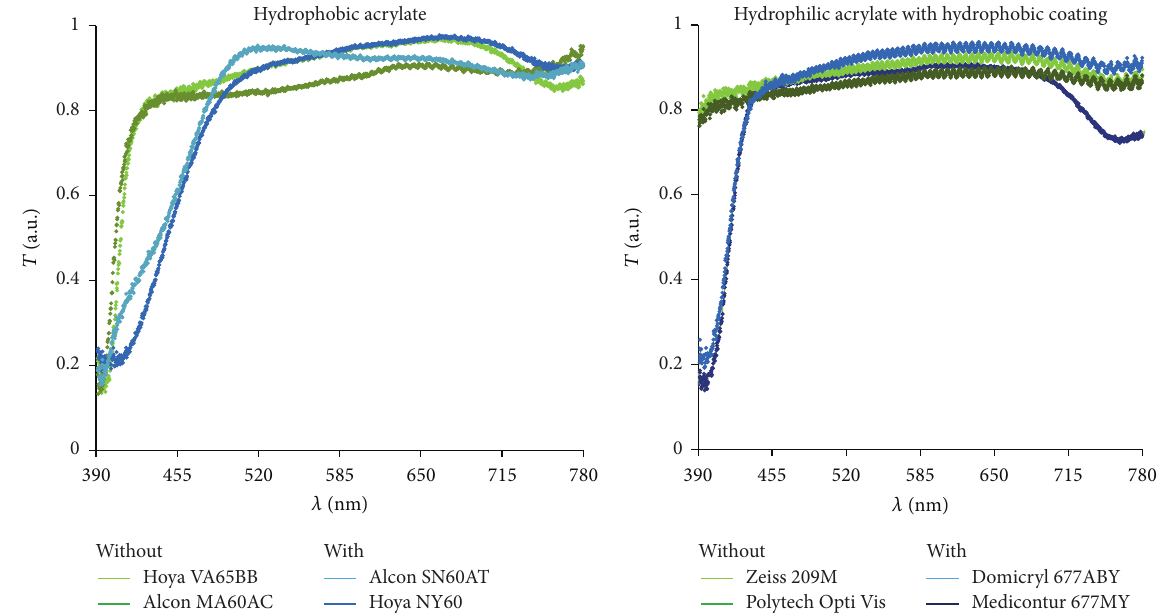
Figure 8: Transmittance spectra of IOLs made from different materials with (blue) and without blue-light filter (green).